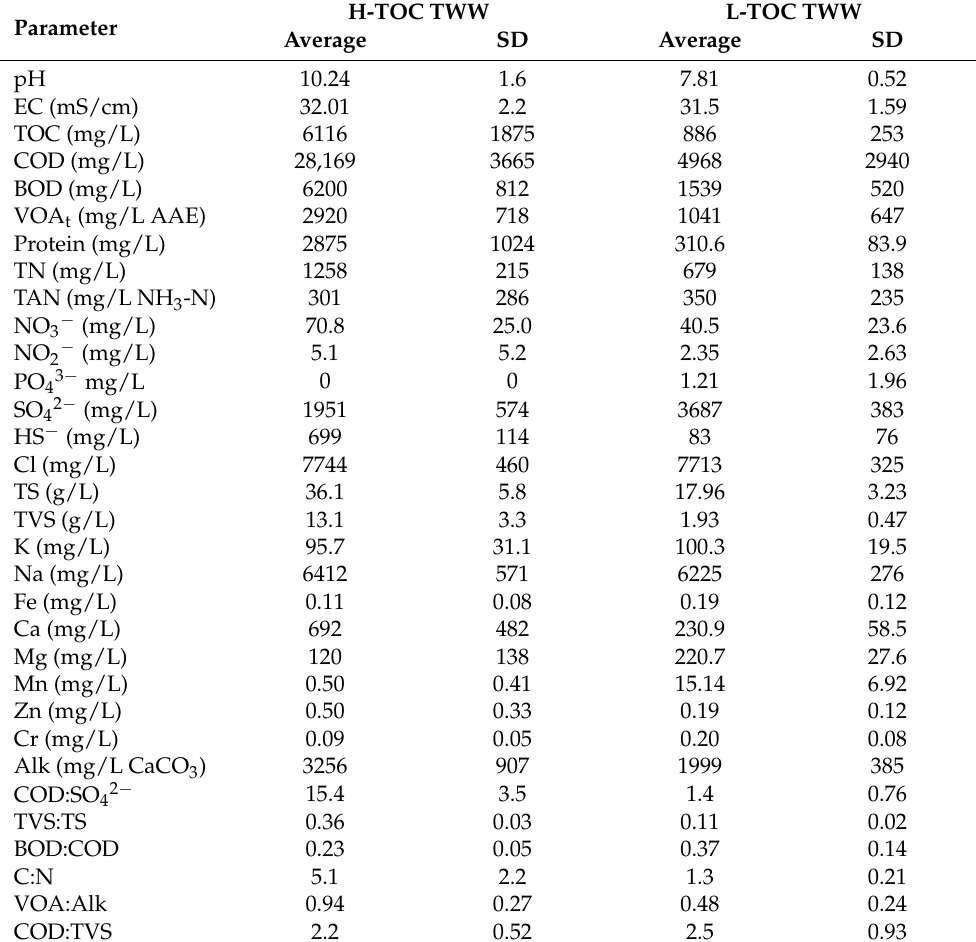
Table 1. Characteristics of tannery wastewater used in this study ( n = 5 batches) adapted from